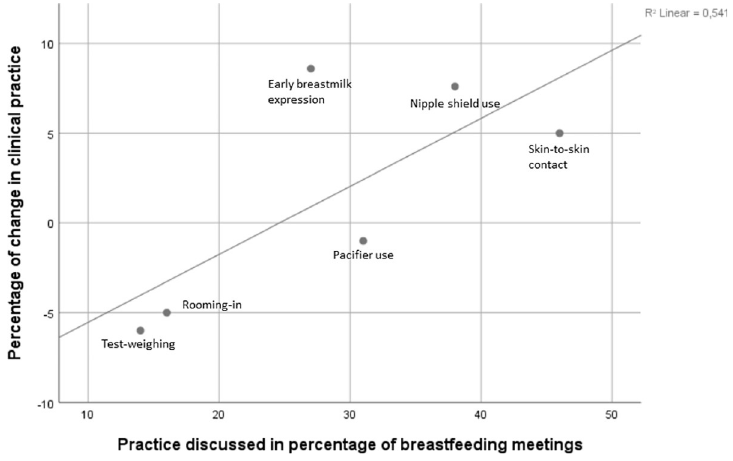
Fig 3. Percentage of change in clinical practice by practice discussed in percentage of breastfeeding meetings.